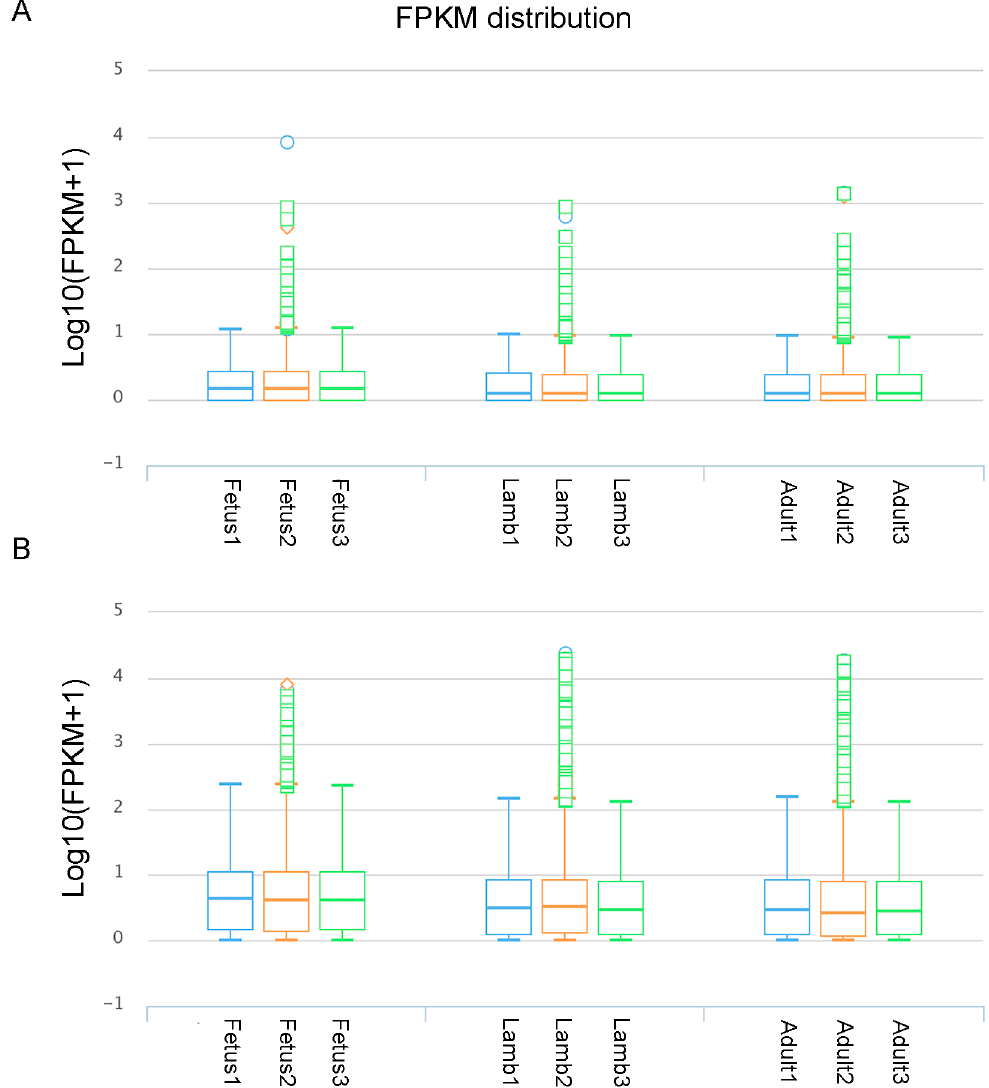
Figure 2. The fragments per kilo base of exon per million fragments mapped (FPKM) distribution of lncRNAs and protein-coding genes at the fetus, lamb, and adult stages during sheep muscle growth, respectively. ( A ) The FPKM distribution of all identified lncRNAs of sheep muscle at three stages. ( B ) The FPKM distribution of protein-coding genes of sheep muscle at three stages.